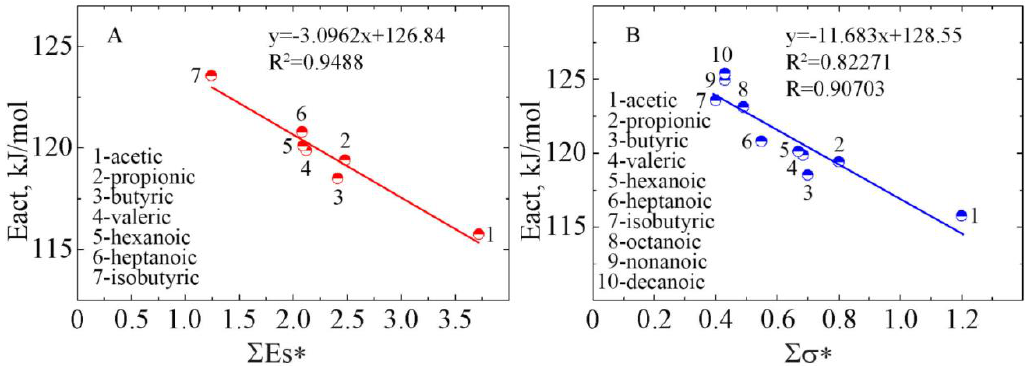
Figure 2. ( A ) Linear correlation between the activation energies of ketonization of reaction series of carboxylic acids (C2–C10) on lCeSi and the sum of the Taft steric constants ( Σ Es*) at the α -carbon atom of carboxylic acids. ( B ) The correlation between the activation energies and the sum of the Taft induction constants ( Σ σ *) at the α -carbon atom of the carboxylic